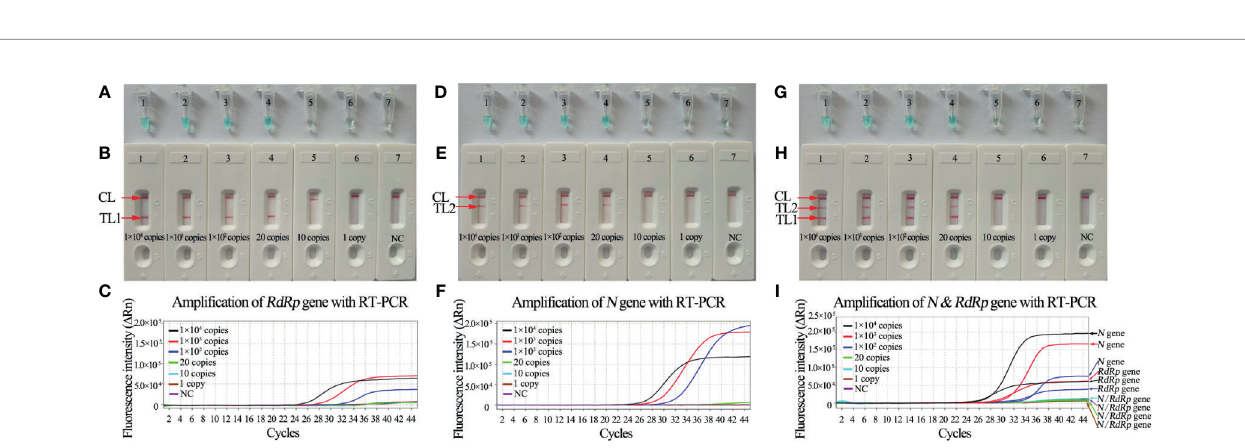
FIGURE 4 | Optimization of the ampli fi cation time for mRT-LAMP-LFB detection. Different ampli fi cation times ( A , 20 min, B , 30 min, C , 40 min, D , 50 min) were tested at 63°C. Biosensors 1-7 represent SARS-CoV-2 genomic RNA levels of 1×10 4 copies, 1×10 3 copies, 1×10 2 copies, 20 copies, 10 copies, and 1 copy per reaction and blank control (DW), respectively. The best sensitivity was observed when the ampli fi cation lasted for 30 min (B) .